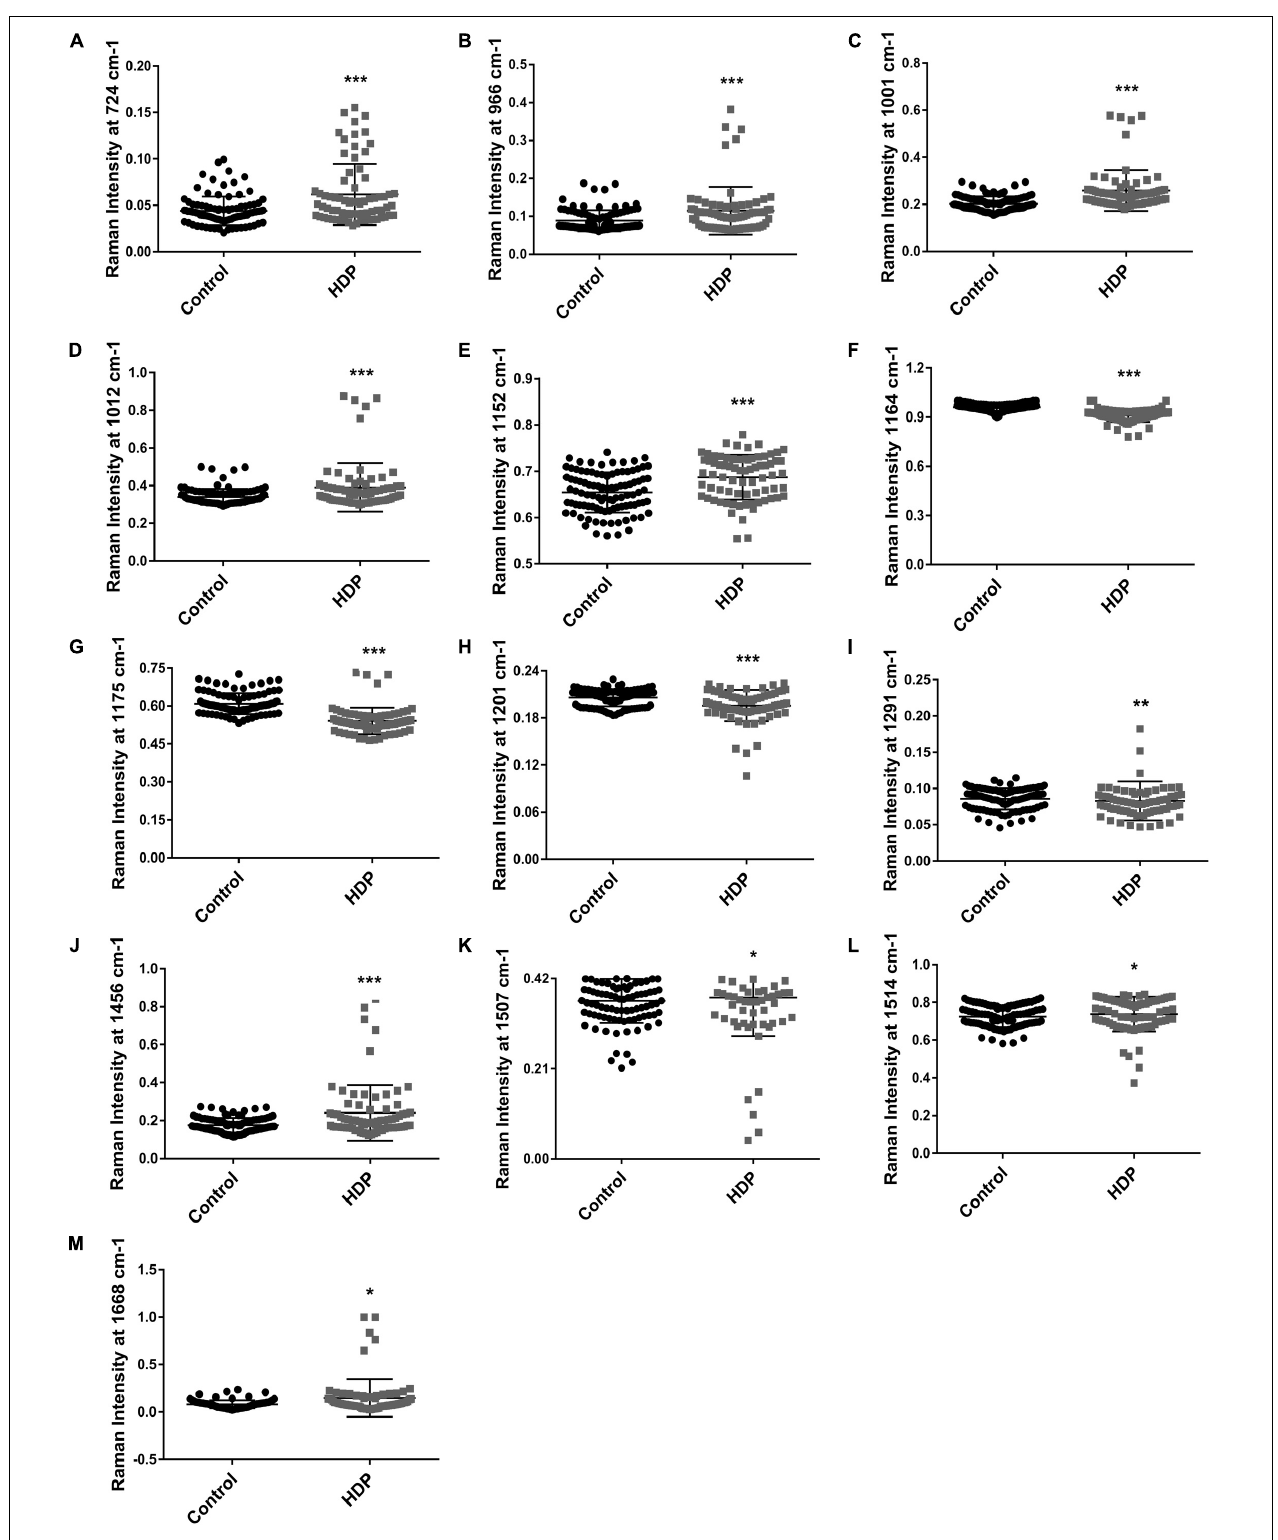
FIGURE 3 | Raman spectral changes from exosome-enriched plasmas. The Raman bands with most variance were further analyzed. Raman intensity from the bands: (A) 724 cm − 1 ; (B) 966 cm − 1 ; (C) 1,001 cm − 1 ; (D) 1,012 cm − 1 ; (E) 1,152 cm − 1 ; (F) 1,164 cm − 1 ; (G) 1,175 cm − 1 ; (H) 1,201 cm − 1 ; (I) 1,291 cm − 1 ; (J) 1,456 cm − 1 ; (K) 1,507 cm − 1 ; (L) 1,514 cm − 1 ; (M) 1,668 cm − 1 . Bar graphs represent mean values ± SEM. * p < 0.05; ** p < 0.01; *** p < 0.001.